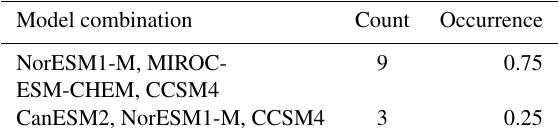
Table C1. Possible model combinations for the Antarctica top three selection, with absolute and relative frequency of occurrence when applying the robustness test.